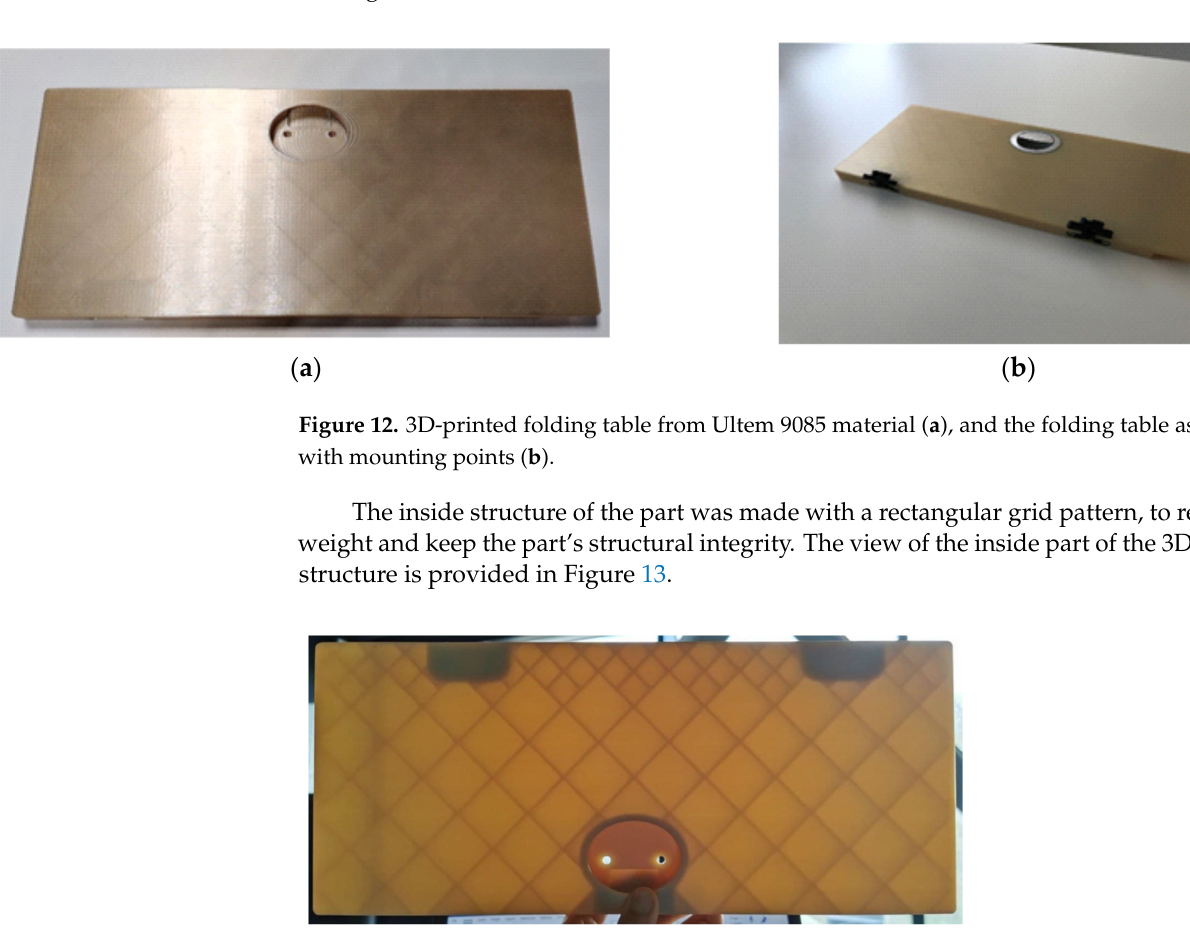
Figure 13. Inside view of the 3D-printed seat folding table.